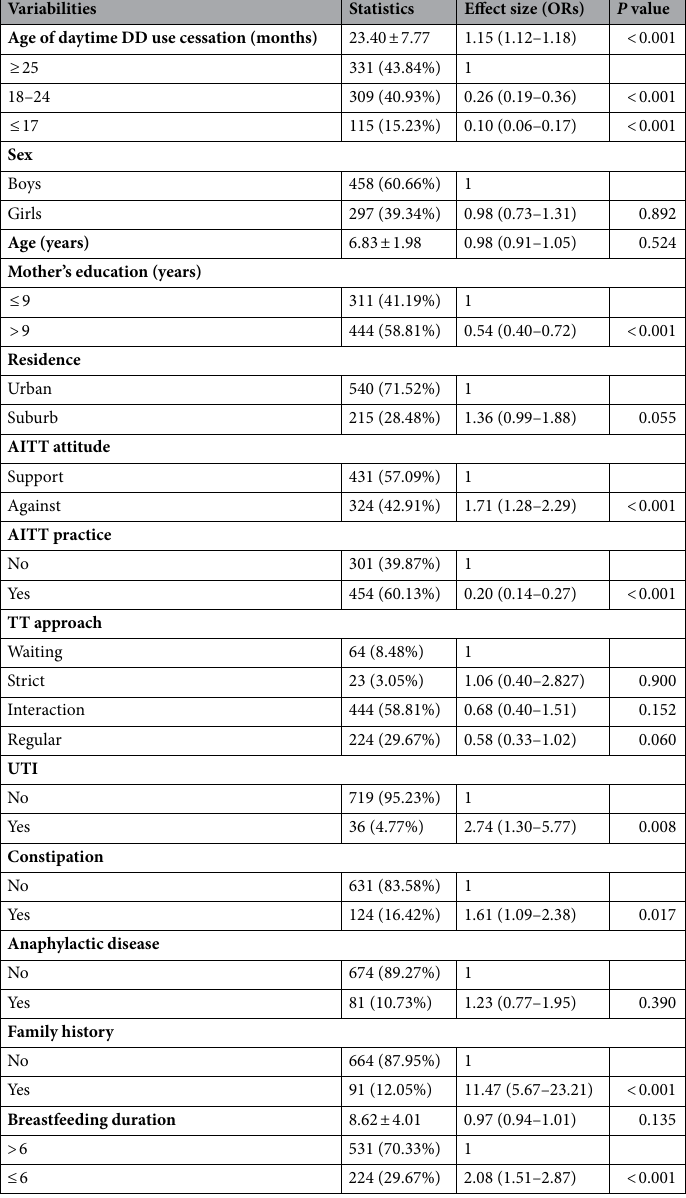
Table 2. The results of univariate logistic regression analysis for factors associated with enuresis. DD disposable diaper, AITT assisted infant toilet training, TT toilet training, UTI urinary tract